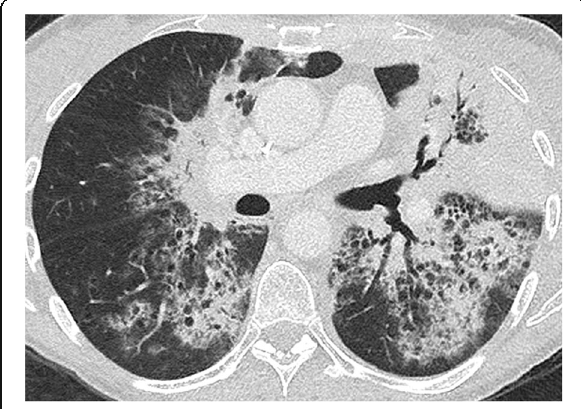
Fig. 6 Immune-related pneumonitis presenting as an organising pneumonia pattern in a patient with metastatic lung cancer that occurred after 13 cycles of anti-PD1 therapy. This axial CT image in lung windowing shows multifocal alveolar consolidations in a subpleural and peribronchovascular location, predominating at the level of the left upper lobe. Although suggestive of a diagnosis of organising pneumonia, infectious or tumoural lesions were excluded by means of a brochoalveolar lavage. Note that numerous round lucencies are visible within the alveolar consolidations, corresponding to associated centrilobular emphysema in this